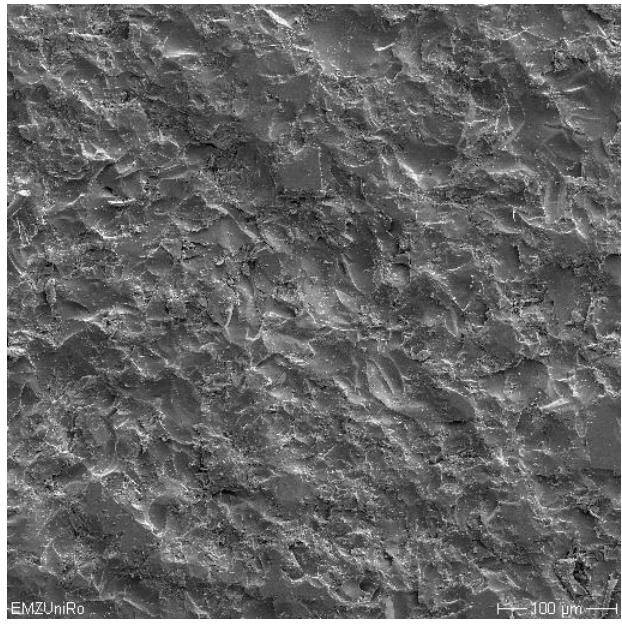
Figure 2. SEM image (magnification: 200X) of a TZP-A specimen coated with glass solder matrix HT1.